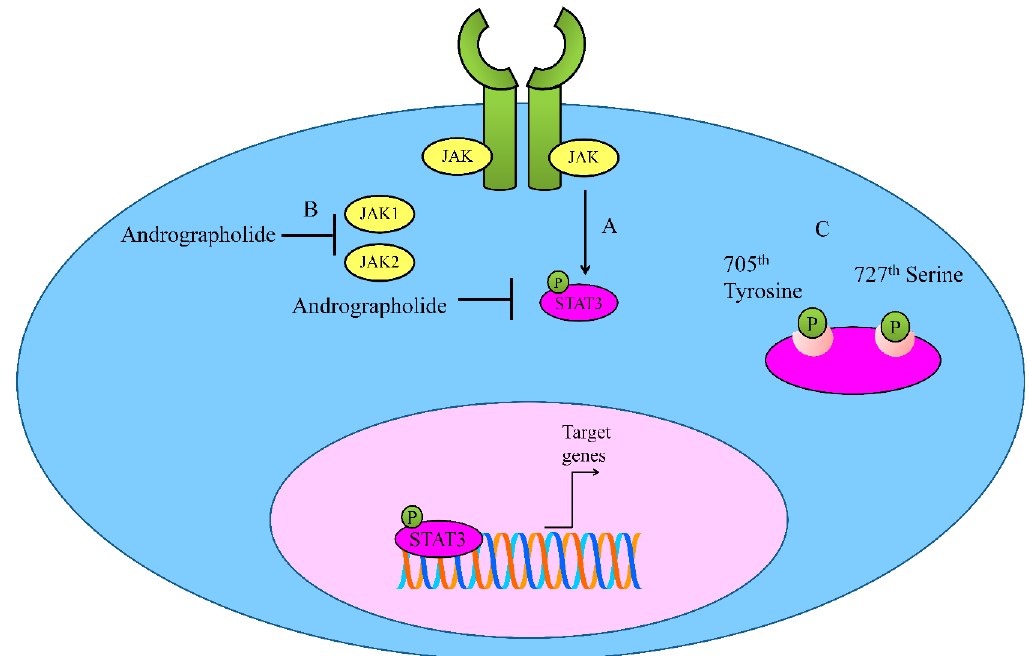
Figure 2. ( A , B ) Regulation of JAK-STAT signaling by Andrographolide. Andrographolide effectively inhibited JAK1, JAK2 and STAT3. ( C ) Andrographolide inhibited phosphorylation of STAT3 on 705th Tyrosine and 727th Serine.